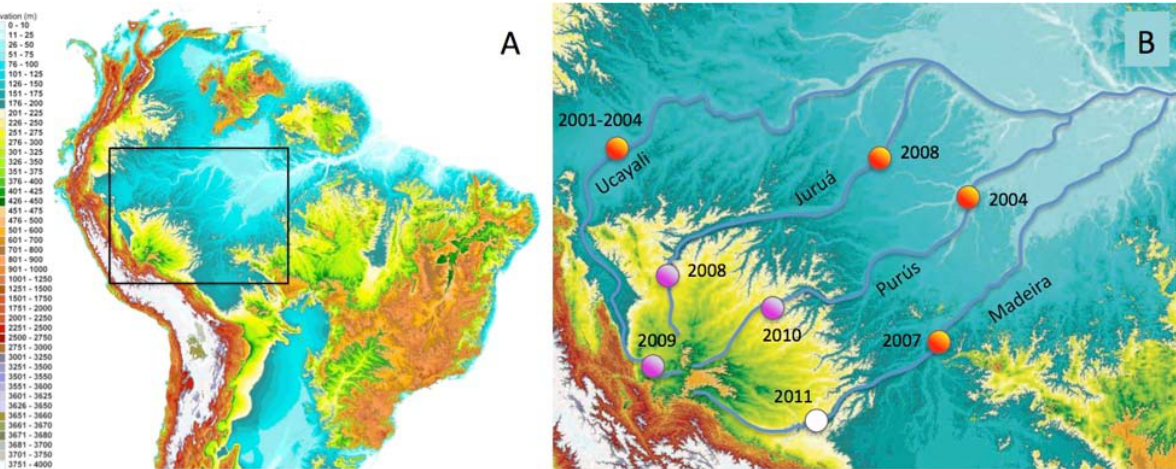
Figure 1. Topography of the Fitzcarrald Arch in southwestern Amazonia. ( A ) Elevational map of tropical South America from Shuttle Radar Topography Mission (SRTM) data in a Digital Elevation Model (DEM). Colors represent 25 m elevation intervals; blue-yellow transition at 200 m. ( B ) Close up of box in panel A. Purple circles indicate expedition locations (with year) between 212–310 m within the Fitzcarrald Arch. White circle indicates a forthcoming expedition. Orange circles indicate locations of comparable aquatic faunal inventories downstream conducted by the authors with colleagues.